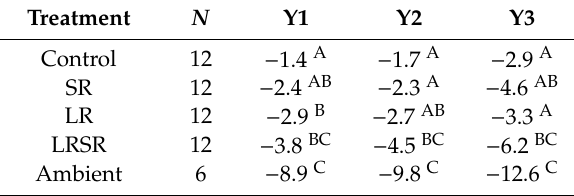
Figure 3. Year 3 mean minimum temperatures (°C) for all four treatment types and ambient temperature for 5-day intervals starting from mid-December through to the end of February for Connecticut and Maine combined. Table 2. Median minimum temperature rank values (°C) for years 1–3 (Y1, Y2, Y3) for all four treatment types and ambient conditions. Values with different letter assignments within columns denotes significant differences using Tukey HSD with α ≤ 0.05.